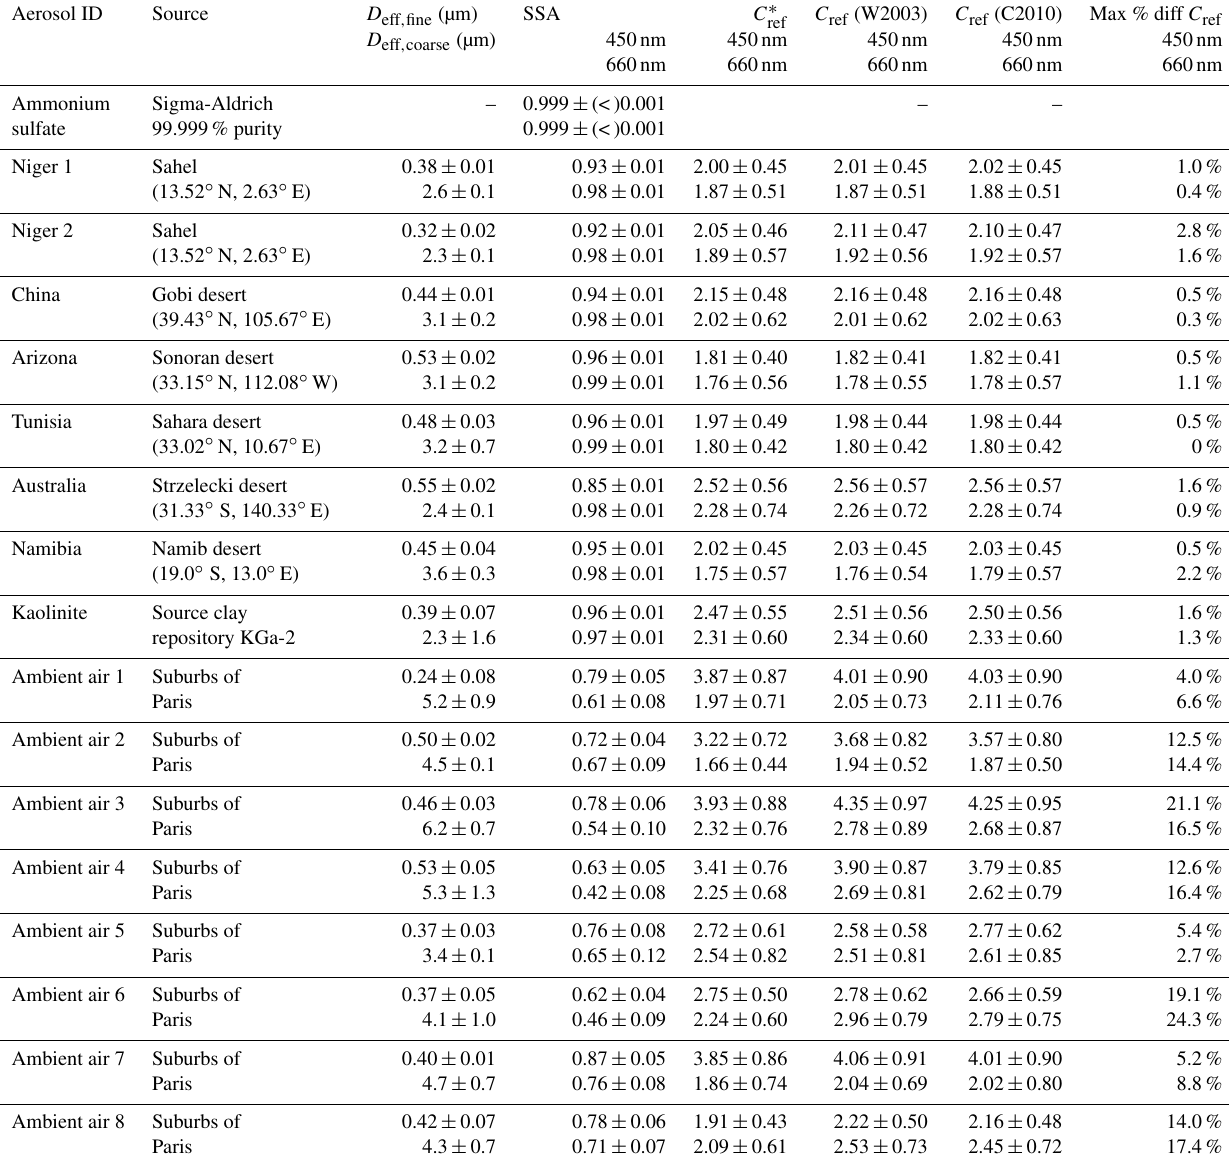
Table 2. Summary of experiments and results. The mean and the standard deviation of D eff , fine , D eff , coarse , SSA at 450 and 660nm, C ∗ C ref (W2003), and C ref (C2010) are reported. As a reminder, C ∗ is the multiple scattering correction obtained when not taking into account ref the loading effect correction in Aethalometer data; C ref (W2003) and C ref (C2010) take the loading effect correction into account by using the parameterizations by Weingartner et al. (2003) (referred to as W2003) and Collaud Coen et al. (2010) (referred to as C2010), respectively. The maximum of the % difference between C ∗ , C ref (W2003), and C ref (C2010) is indicated in the ref